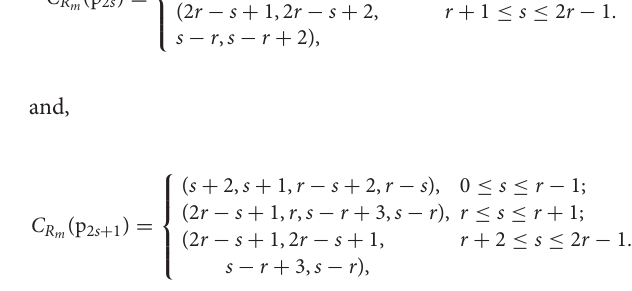
FIGURE 1 | The generalized Petersen graph P (8,2).